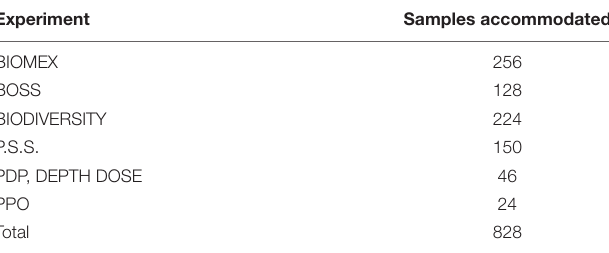
TABLE 2 | Amount of samples in